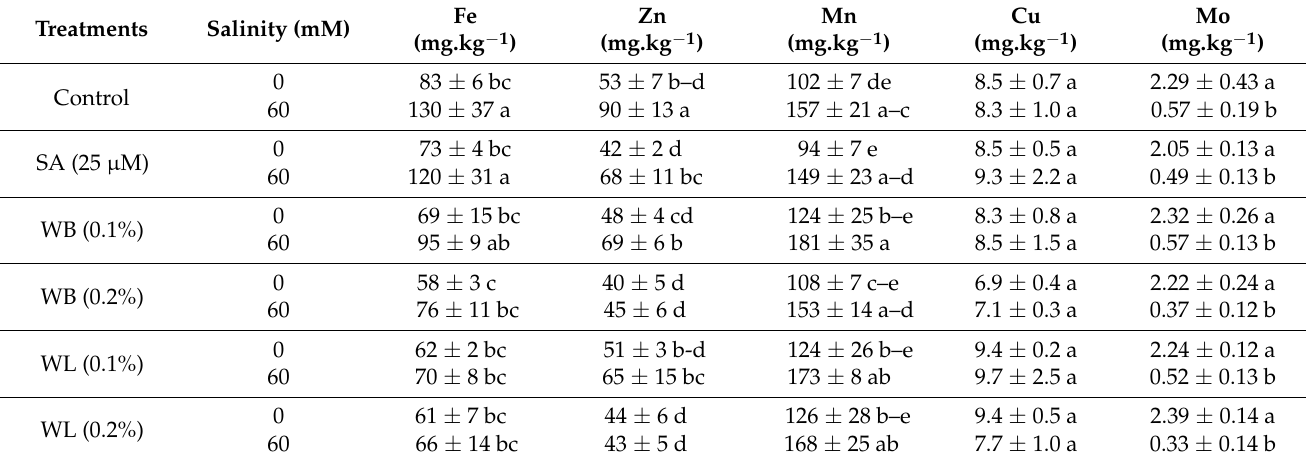
Table 6. Changes in micronutrient (Fe, Zn, Mn, Cu, Mo) concentrations of 30 DAS hydroponically grown maize ( Zea mays cv. Caramelo) plants in response to salinity (non-salinity stress, 0 mM; salinity stress, 60 mM) and biostimulant applications (SA, salicylic acid (25 µ M); WB, willow bark